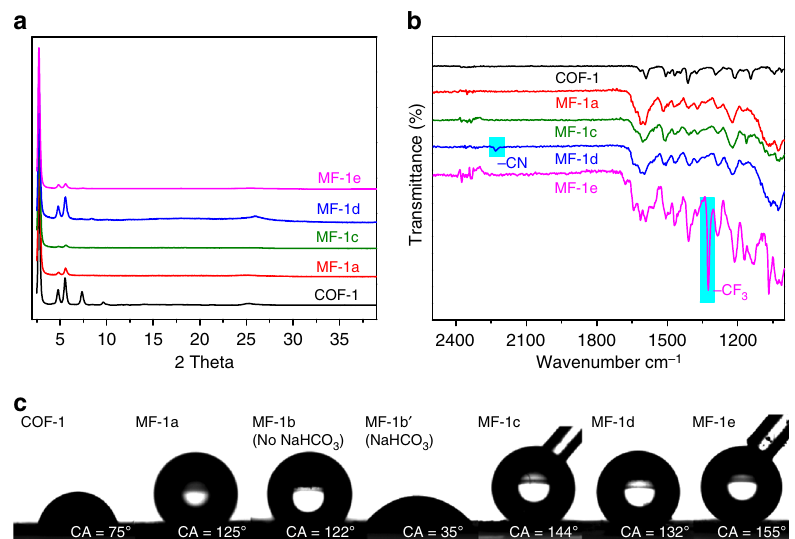
Fig. 5 Structural characterization and surface properties of MF-1 series. a Powder XRD patterns of COF-1 (black), MF-1a (red), MF-1c (green), MF-1d (blue), and MF-1-e (purple). b FT-IR spectra of COF-1 and MF-1a, c-e. The peaks highlighted in cyan are characteristic vibrations from these functional groups. c Water contact angles (CA) of water droplet on the pressed pellet of COF-1 and MF-1a-e. MF-1b ′ is the NaHCO 3 -treated MF-1b that undergoes partial ester